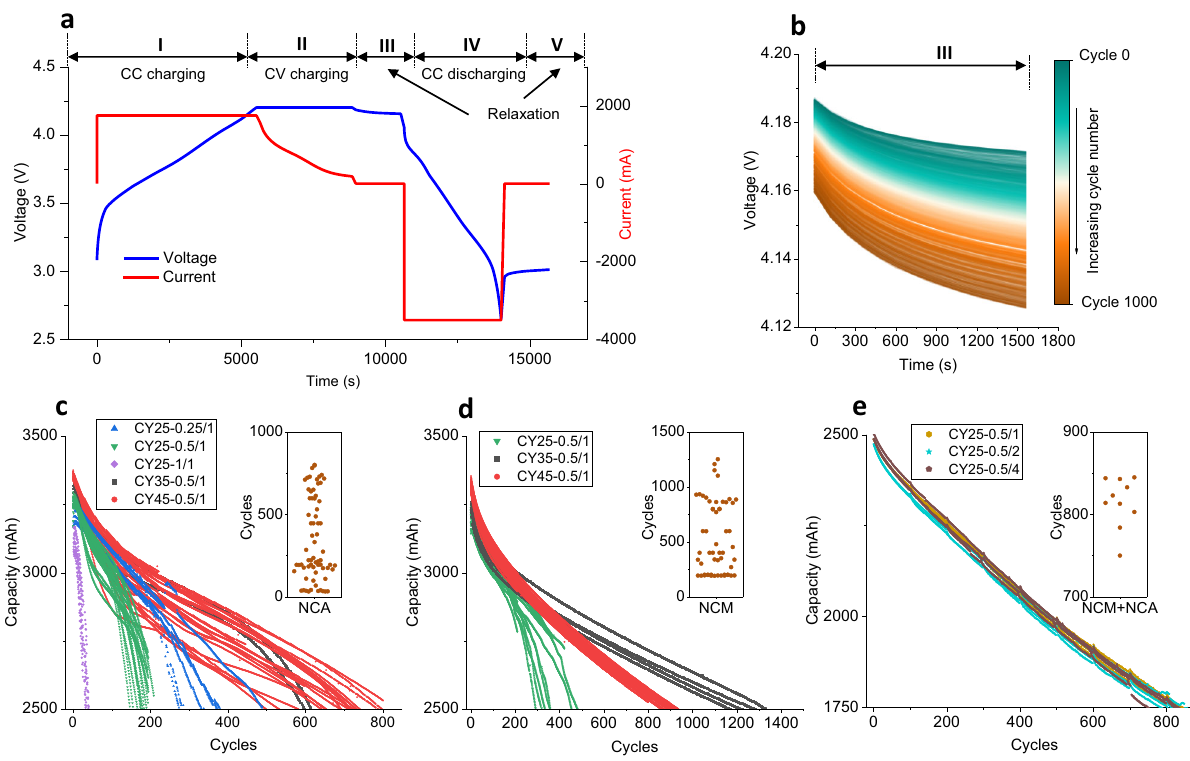
Fig. 1 Battery cycling data. Voltage and current pro fi le in the fi rst cycle of one CY25-0.5/1 NCA battery ( a ). A plot of relaxation voltage change (region III) while cycling for one NCA cell ( b ). NCA battery discharge capacity (until 71% of nominal capacity) versus cycle number of NCA battery ( c ), NCM battery ( d ), and NCM + NCA battery ( e ). The embedded plots in c , d , and e are the cycle distribution of cells at around 71% of nominal capacity, the points are offset randomly in the horizontal direction to avoid overlapping.